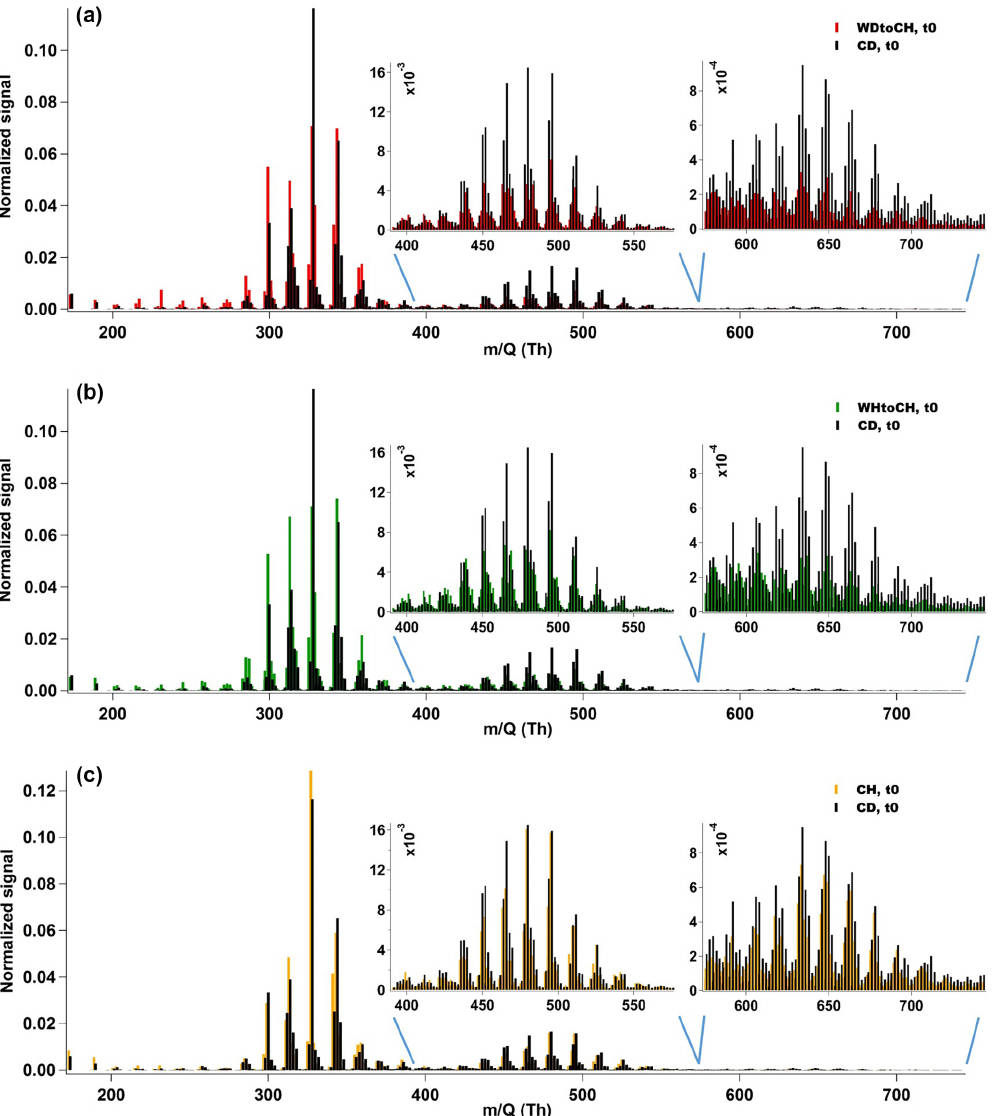
Figure 3. CIMS mass spectra (normalized to the sum of signal of all detected CHOI compounds) of experiments WDtoCH and CD (a) , WHtoCH and CD (b) , and CH and CD (c) at t 0. Inserts show enlarged regions of dimers (left) and trimers